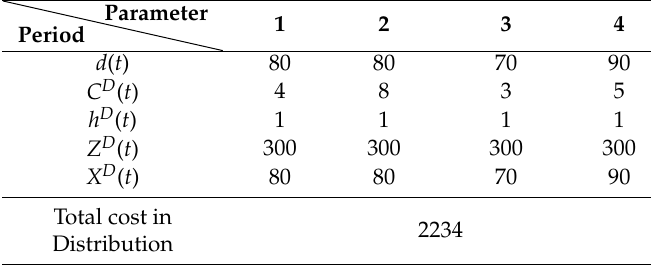
Table 4. Distribution Model